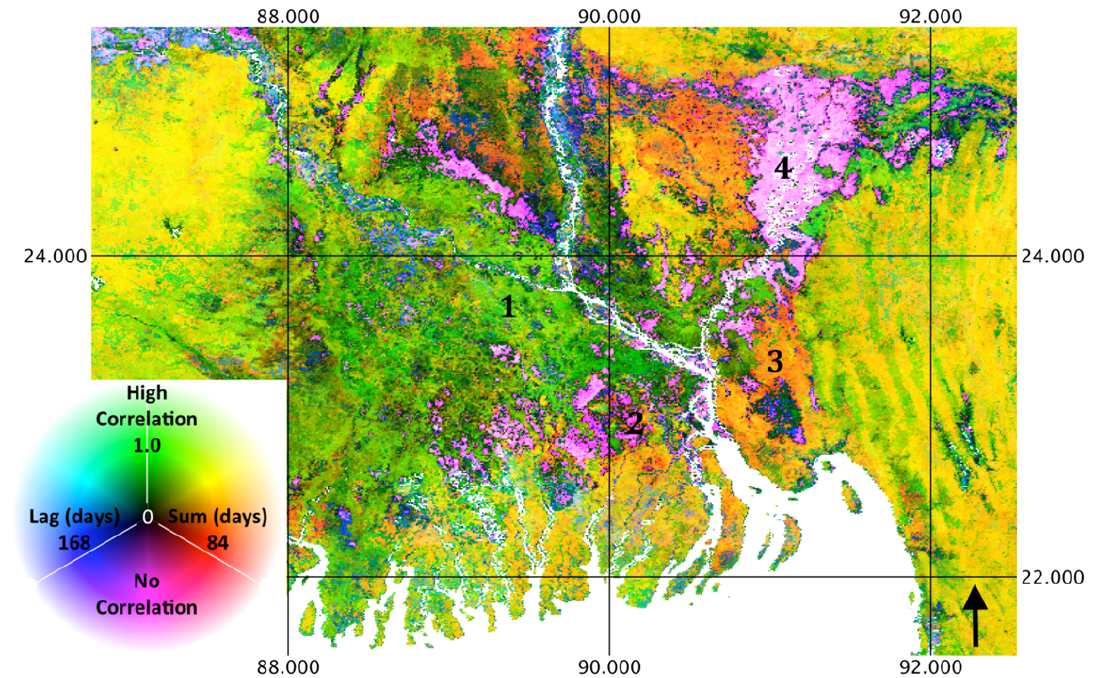
Figure 9. Precipitation correlation, lag and summation period illustrating different cropping systems in the Ganges River Delta, Bangladesh. 1-km